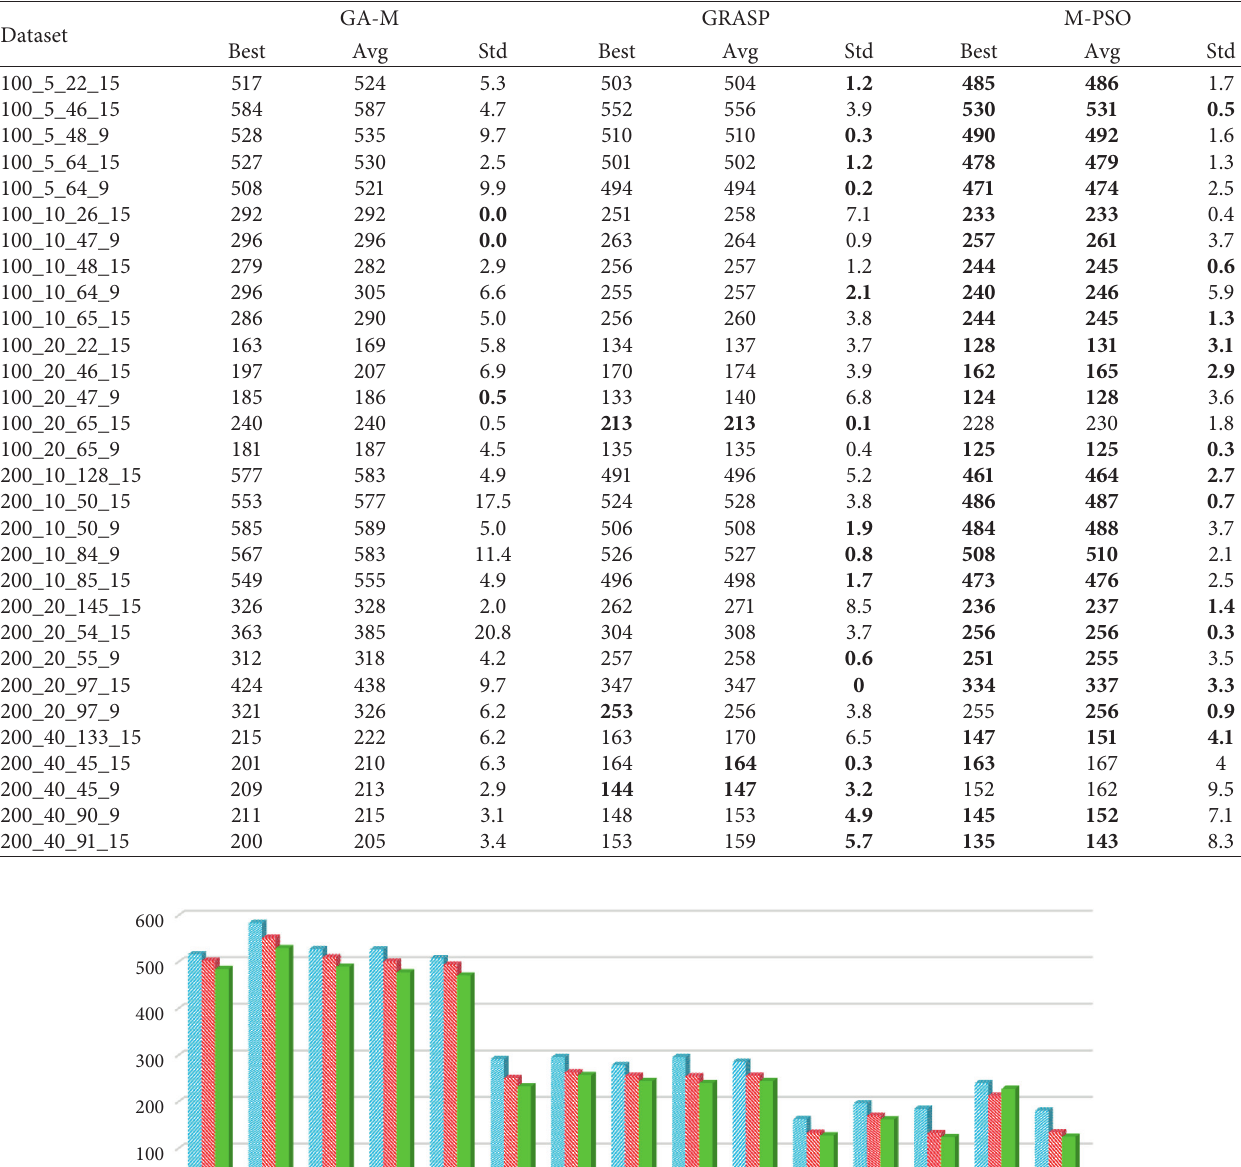
Table 6: The experiment results on the iMOPSE dataset.